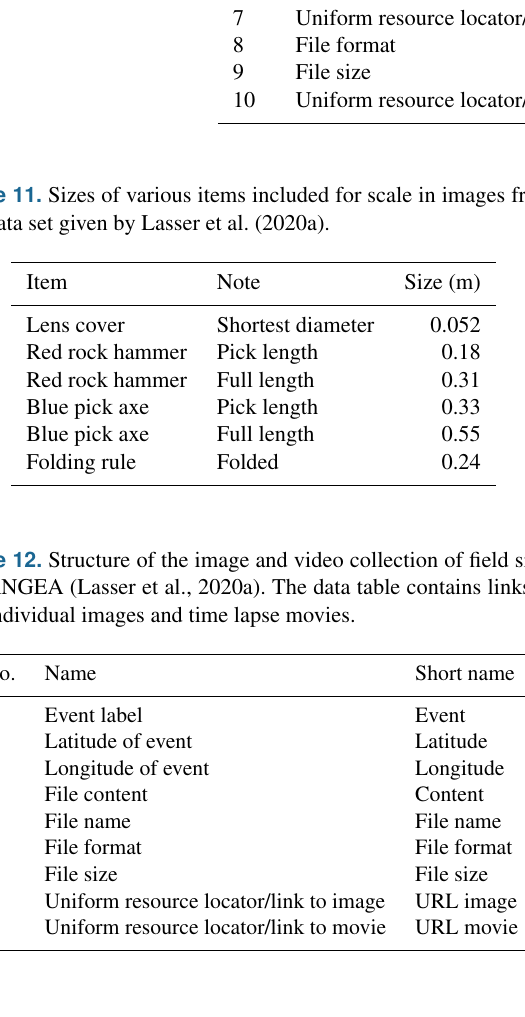
Uniform resource locator/link to